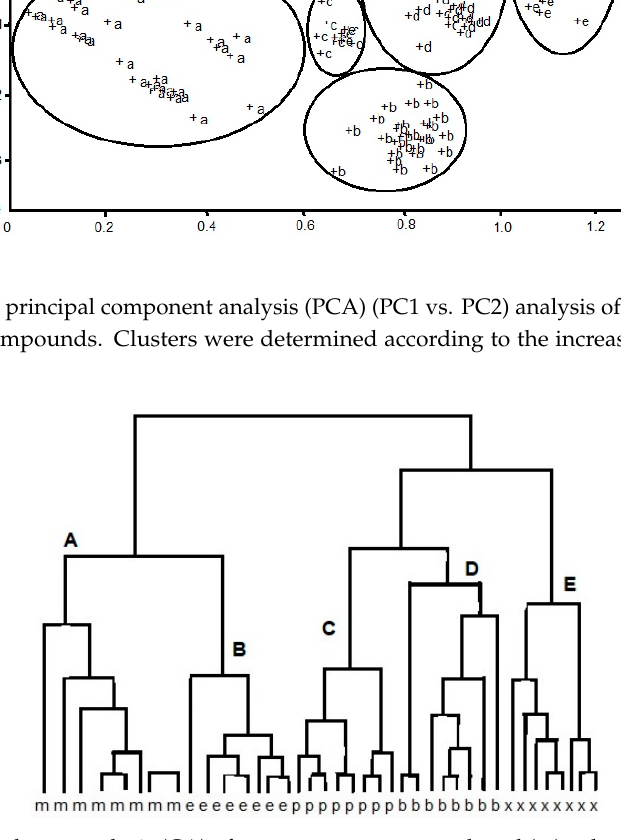
Figure 2. Result of cluster analysis (CA) of e-nose response on methanol (m), ethanol (e), propanol (p), butanol (b), and methyl-butanol (x), resulting in clusters A, B, C, D,